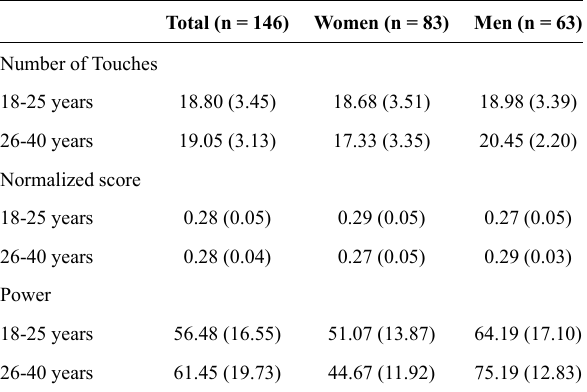
Table 2 - Mean and standard deviation for the Closed Kinetic Chain Upper Extremity Stability Test scores according to gender and age cate- gory (n = 146).